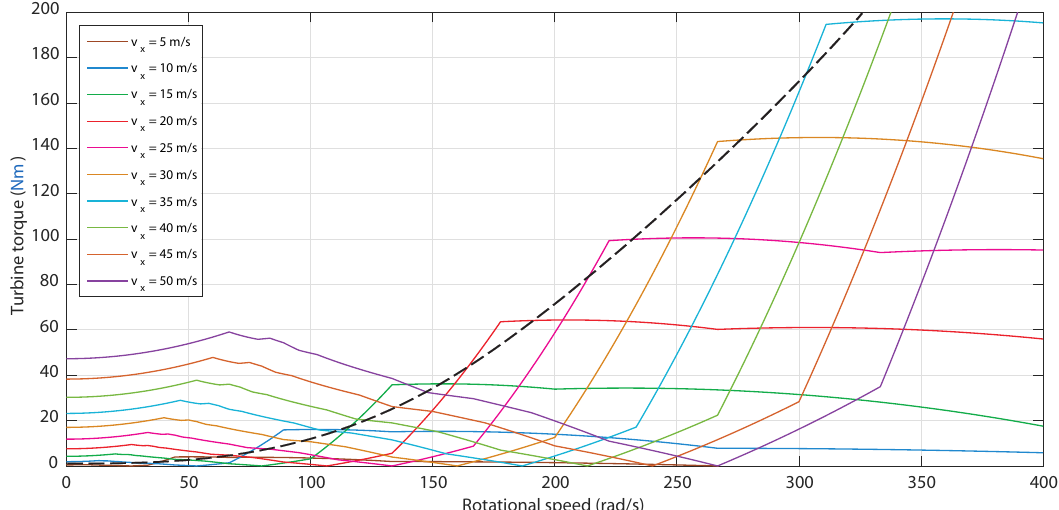
Figure 15. Turbine torque vs rotor rotational speed for different incoming airflow